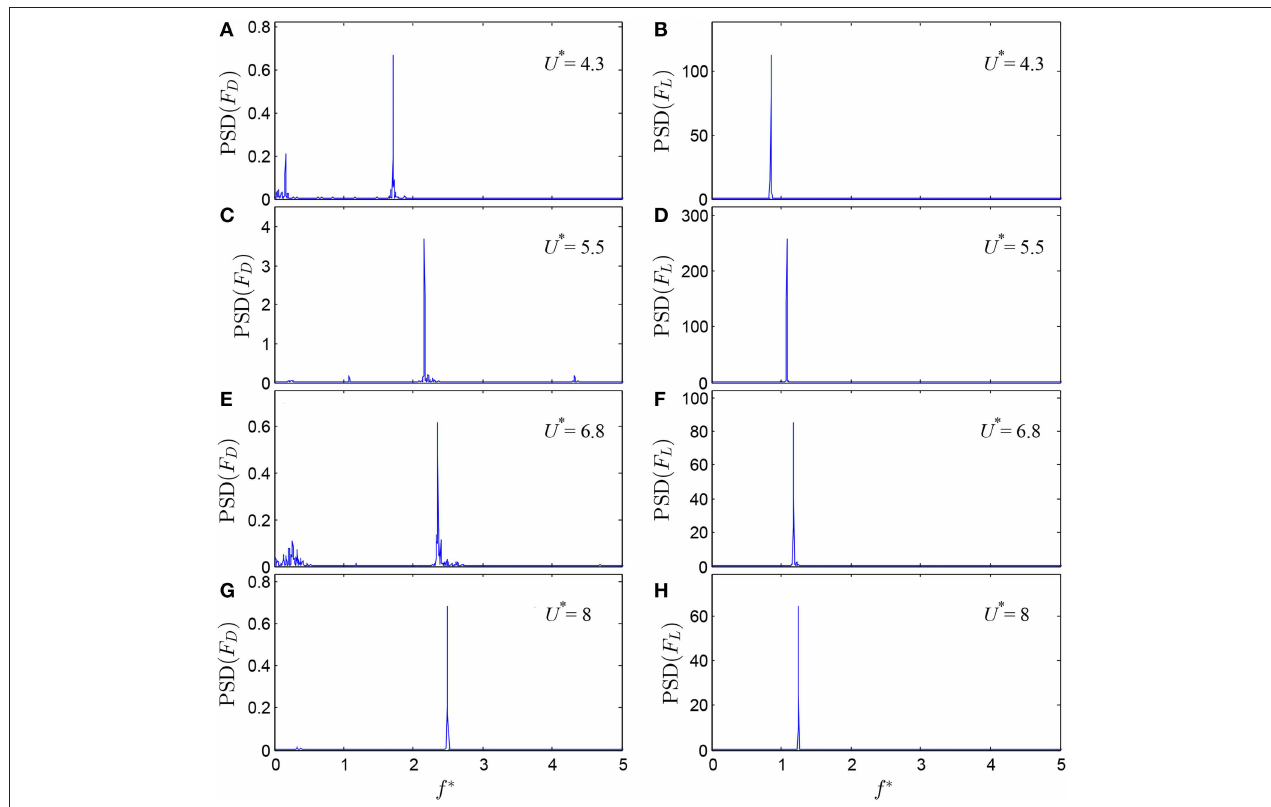
FIGURE 6 | Spectra of the drag (left column) and lift (right column) at different reduced velocities: (A,B) U ∗ U ∗ 6.8 (transition), and (G,H) U ∗ =